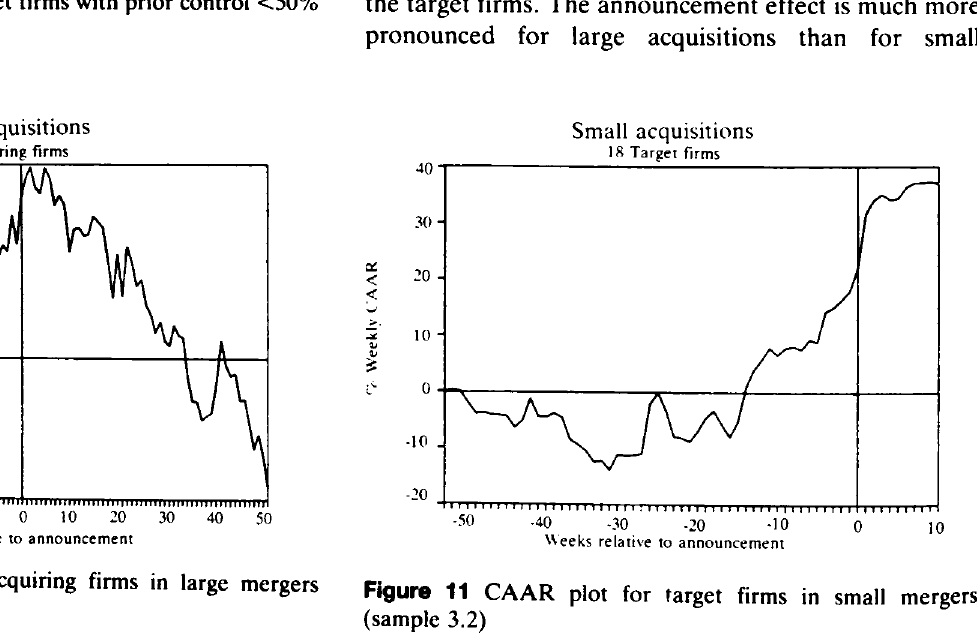
Figure 9 CAAR plot for acquiring firms in large mergers (sample 3.1)